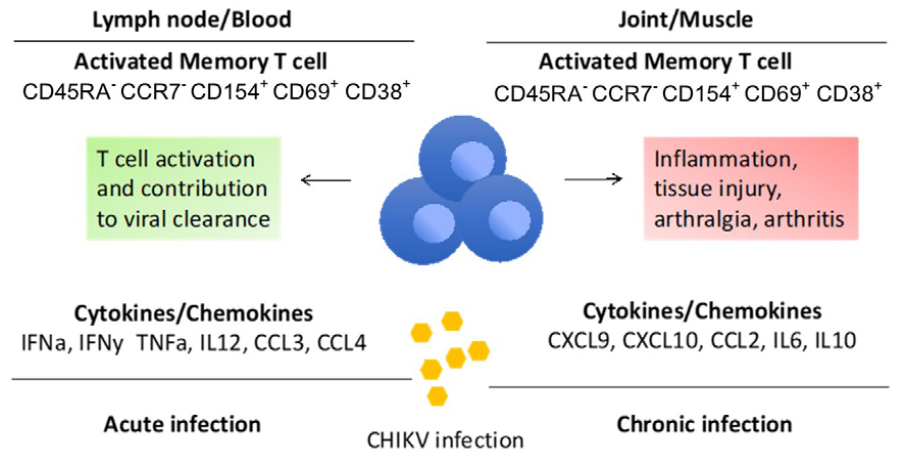
Figure 3. T cell response to CHIKV in acute and chronic infection.